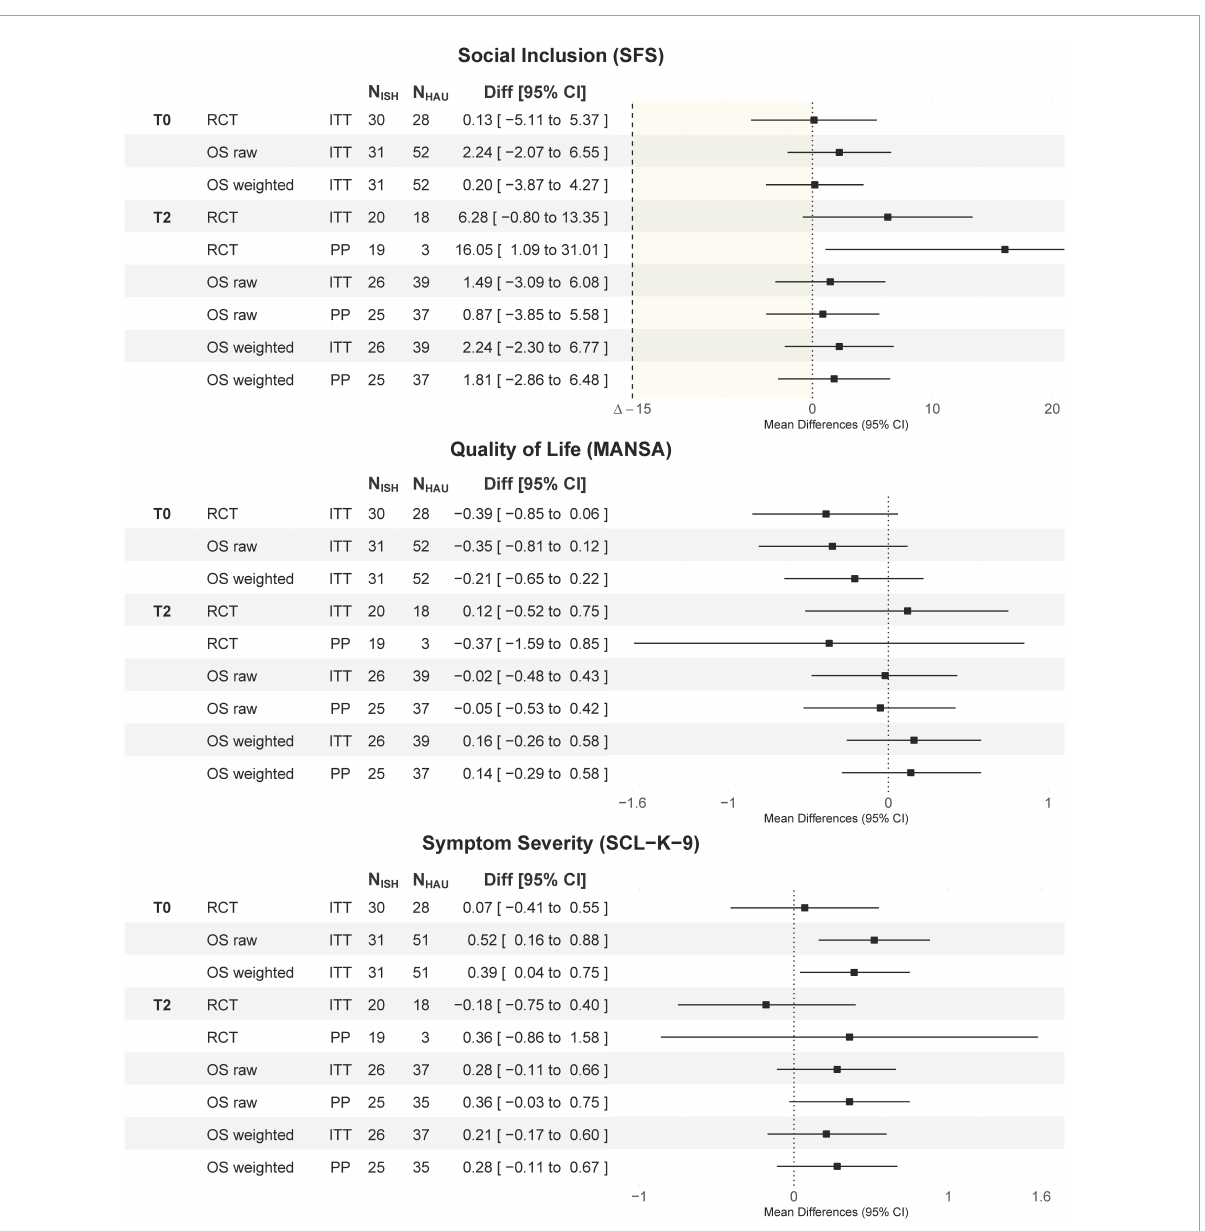
FIGURE4 Mean differences (mean ISH -mean HAU ) and 95% CI of differences. Outcome analysis in social inclusion, quality of life, and psychiatric symptoms at baseline (T0) and after 12 months (T2) separately for the RCT, the unweighted, and IPTW-weighted OS study arms. Every analysis was conducted for both the ITT and the PP sample. RCT, randomized controlled study; OS, observational study; ITT, intent to treat; PP, per-protocol; N, sample size; ISH, Independent Supported Housing; HAU, housing as usual; Diff, mean differences; SFS, Social Functioning Scale, MANSA, Manchester Short Assessment of Quality of Life; SCL-K-9, 9-item Symptom Checklist; IPTW, inverse probability of treatment